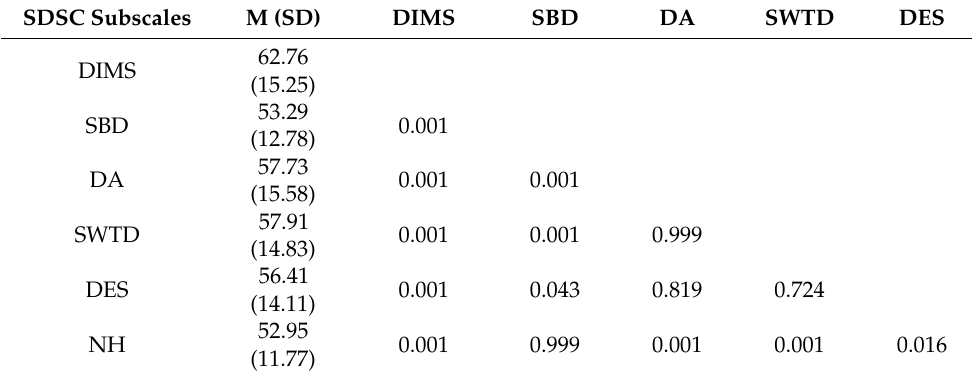
Table 2. Means, standard deviations in SDSC subscales, and p -values of their comparisons.